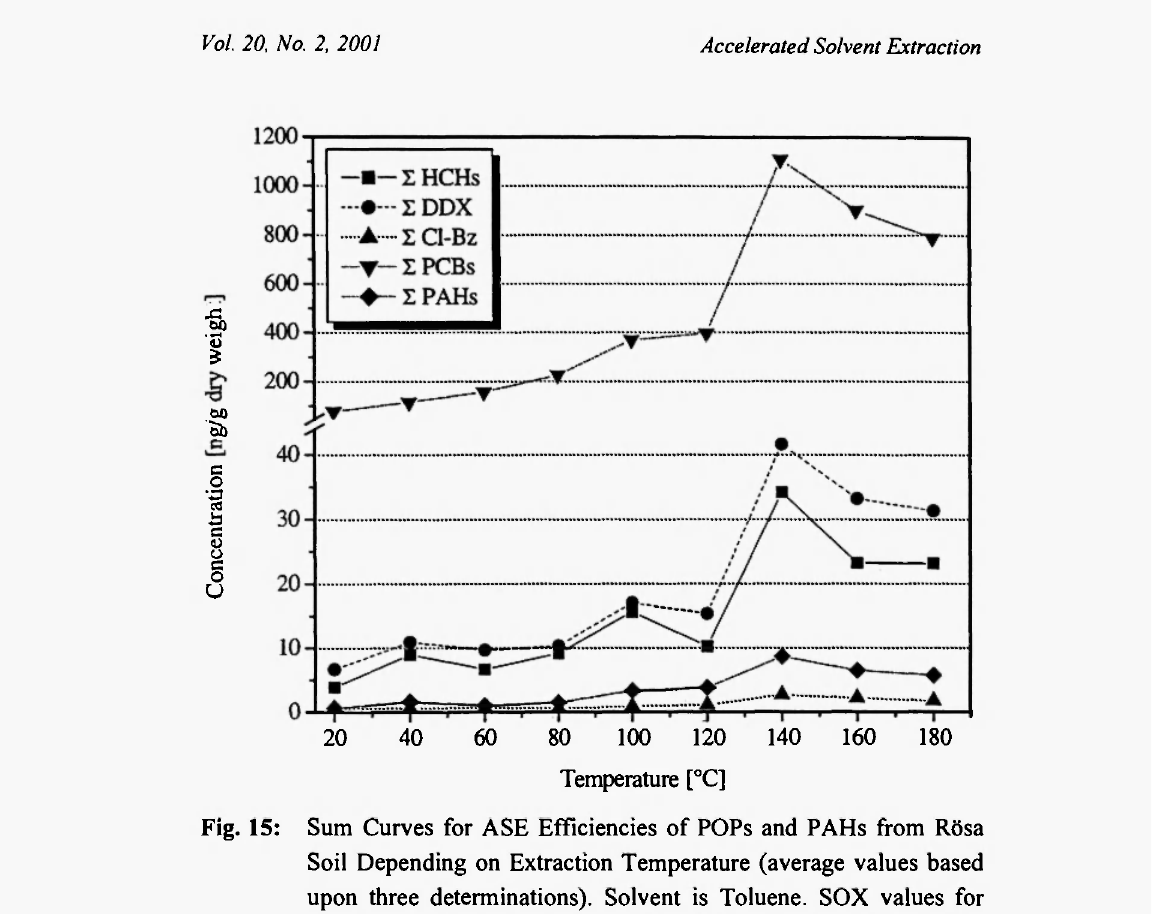
Fig. 15: Sum Curves for ASE Efficiencies of POPs and PAHs from Rösa Soil Depending on Extraction Temperature (average values based upon three determinations). Solvent is Toluene. SOX values for comparison (ng/g of dry weight): ZHCHs, 14.2; ZDDX, 10.5; ZPCBs, 0.75; ZPAHs, 122; ECl-Bz,